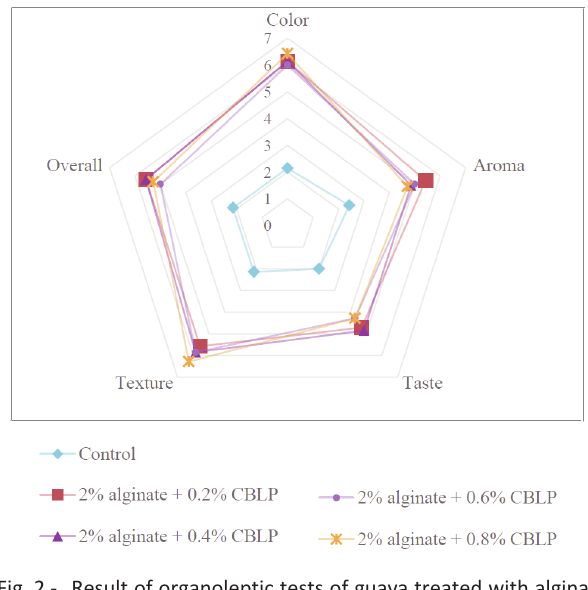
Fig. 2 ­ Result of organoleptic tests of guava treated with algina­ te­based edible coating enriched with different concen­ tration of Cyclea barabata leaves powder